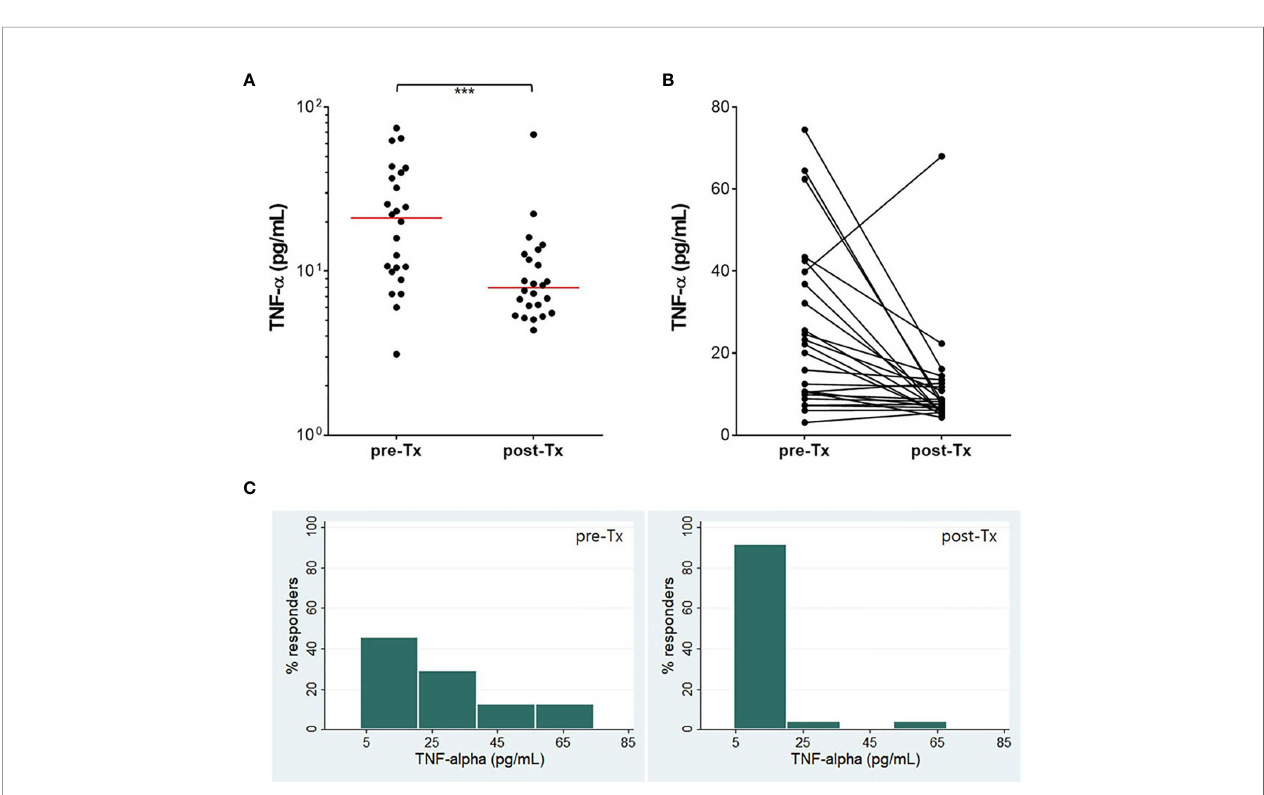
FIGURE 6 | Treatment ef fi cacy measured by TNF- a . TNF- a concentration (nil) was signi fi cantly reduced after TB treatment (A, B) . The proportion of responders with a high level of TNF- a decreased, while that of responders with a low level of TNF- a dramatically increased (C) . The horizontal red line represents the median value of TNF- a . ***P < 0.001 by Wilcoxon signed rank test, Tx, treatment.